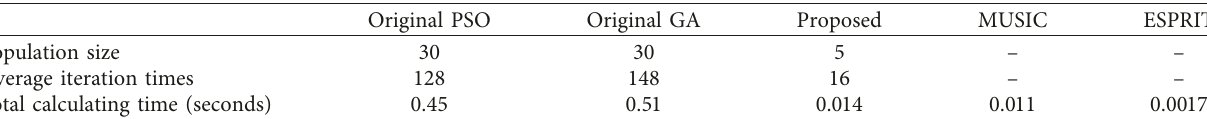
Table 6: Comparison of calculating time of original GA, PSO, and ESPRIT and the proposed